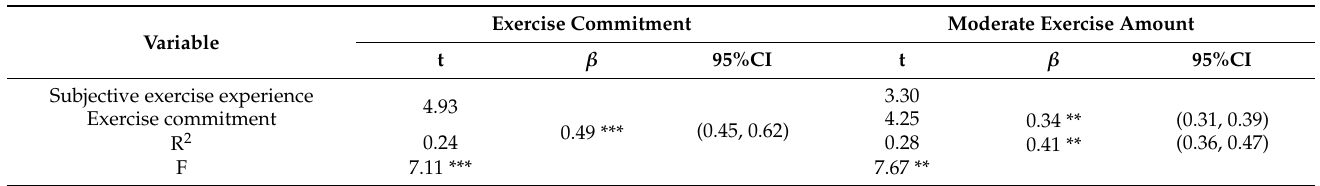
Table 7. The mediating effect of exercise commitment between subjective exercise experience and moderate exercise amount.